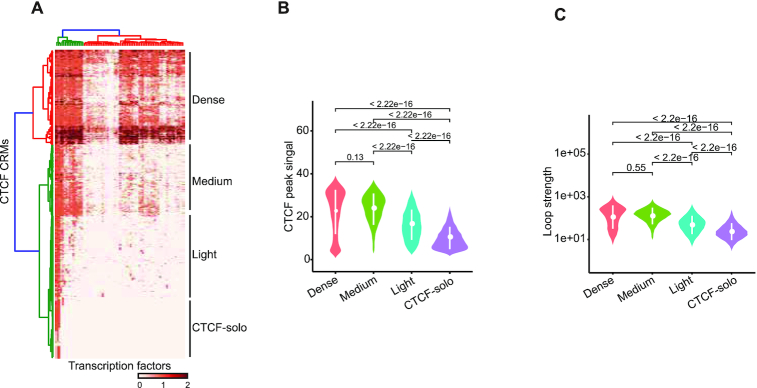
Genomic features of CTCF loop anchors. (A) Heatmap displaying the density of CTCF co-localized factors grouped by hierarchical clustering. Dense, medium, light and CTCF-solo binding sites represent different frequency of factor co-binding, respectively. CTCF co-localized factors used in the heatmap were listed in Supplemental Table S6. (B) Violin plot showing the distribution of CTCF peak signal which is the value of seventh column in the narrowPeak file generated by MACS2. (C) The distribution of CTCF loop strength among four CTCF binding groups with log10 scale on y axis. Loop strength is represented as the sum of the anchor mediated all loop PET tag counts. P value in (B) and (C) was calculated using Wilcoxon rank sum test.